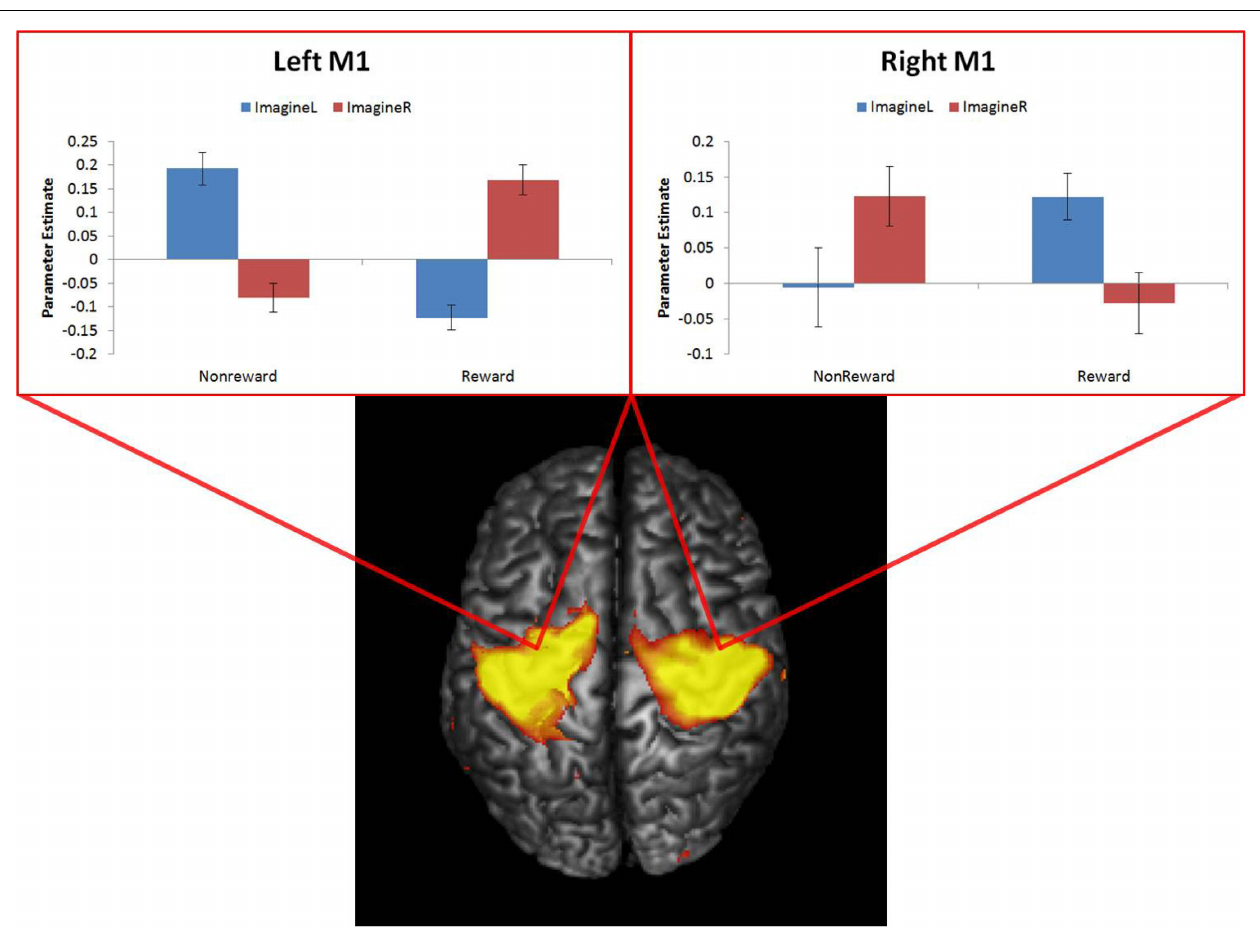
FIGURE 3 | Parameter estimates extracted from left and right motor cortex for Imagining Rewarded and Imagining Non-Rewarded outcomes associated with left and right button presses. ImagineL, ImagineLeft; ImagineR,